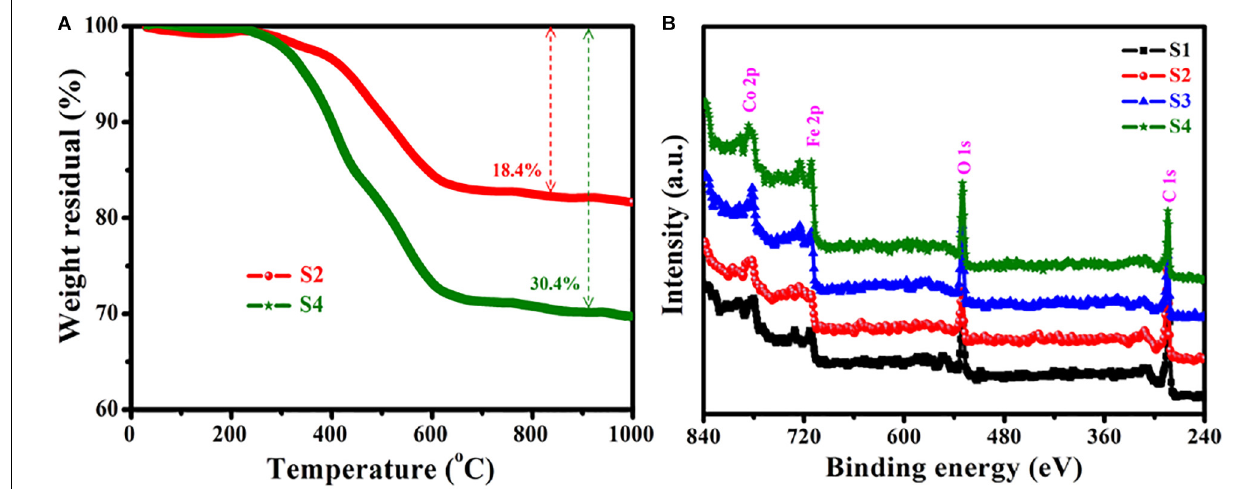
FIGURE 3 | (A) TGA curves, and (B) XPS spectra of the obtained samples.